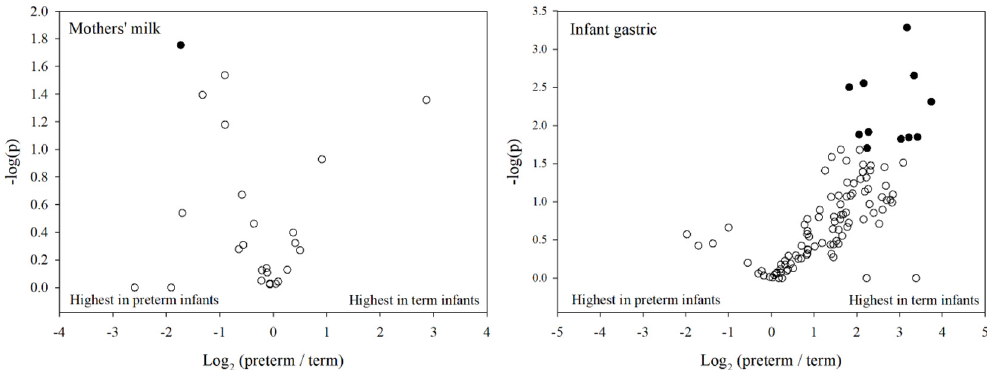
Figure 4. Volcano plots depicting fold change in total peptide intensity from individual proteins ( x- axis, logarithmic) and p -value (y-axis, logarithmic) between term and preterm infant milk and gastric samples. Filled circles indicate the protein was significantly different between preterm and term infants ( p < 0.05), whereas the hollow circles are non-significant.